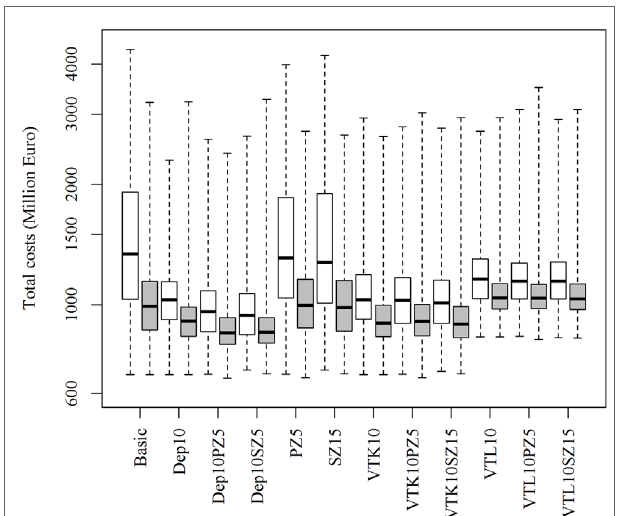
FigUre 5 | Total costs using different strategies to control 1,000 simulated FMD epidemics in Denmark, all initiated in cattle herds, when the probability of basic detection is decreased (white boxes) or increased (gray boxes) by 25% . The basic scenario represents the EU and Danish control regulations (Basic), combined with the enlargement of the protection zone to 5 km (PZ5) and the surveillance zone to 15 km (SZ15), pre-emptive depopulation (Dep) over a 1-km radius around detected herds, and suppressive (VTK) or protective (VTL) emergency vaccination over a surveillances zones are also included.